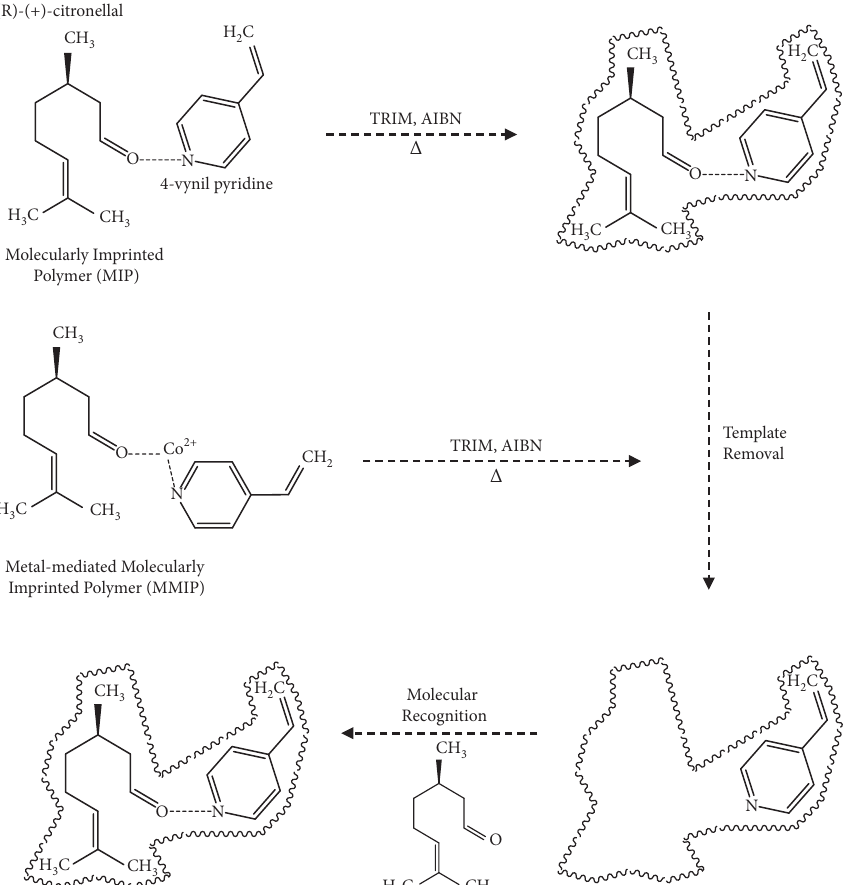
Figure 1: Schematic representation of MIP preparation and MMIP using Co(II) ion as a metal pivot for (R)-(+)-citronellal recognition.